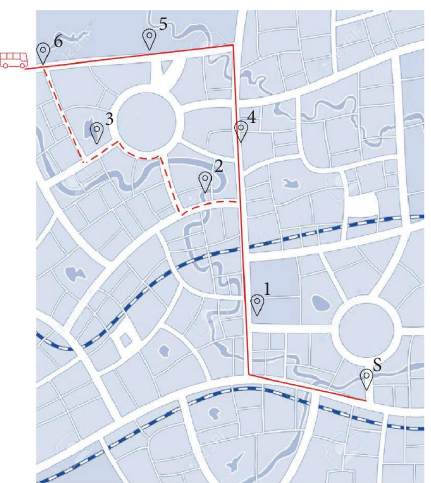
Figure 1: Example of a line with two routes for the